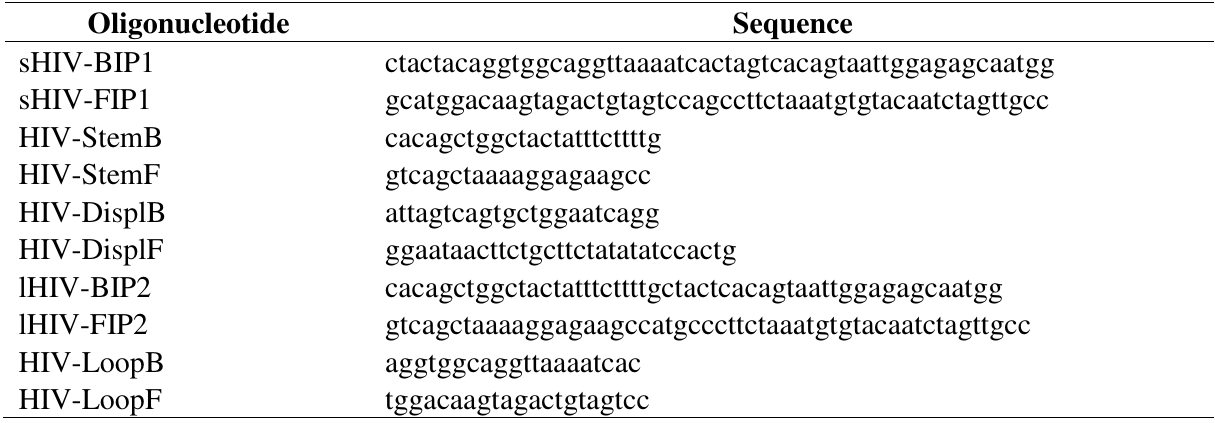
Table 2. Sequences of oligonucleotides designed for HIV-AT.